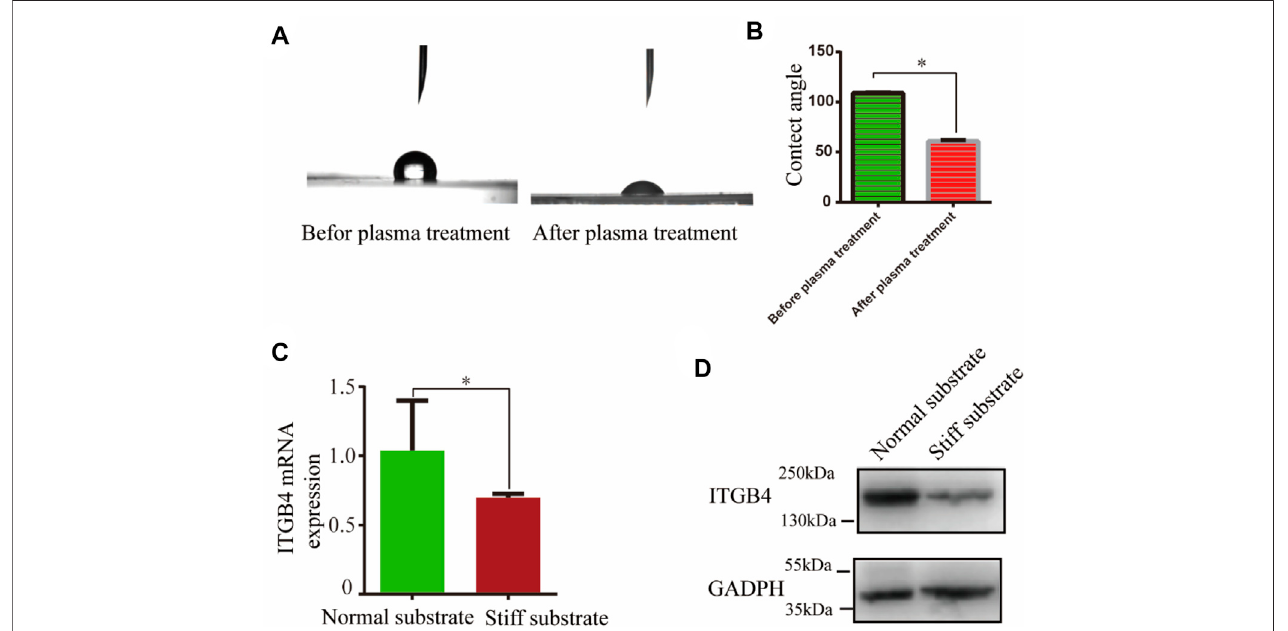
FIGURE5 | Normal and stiff substrate models were constructed in vitro . (A,B) Detection ofcontact angle and the contact angle before and after plasma treatment (C,D) ITGB4expression of16HBE14o-cells on thenormal and stiff substrate by RT-PCR and western blot. ( n =3 independent experiments, * p < 0.05, ** p < 0.01). Data are presented as mean ±